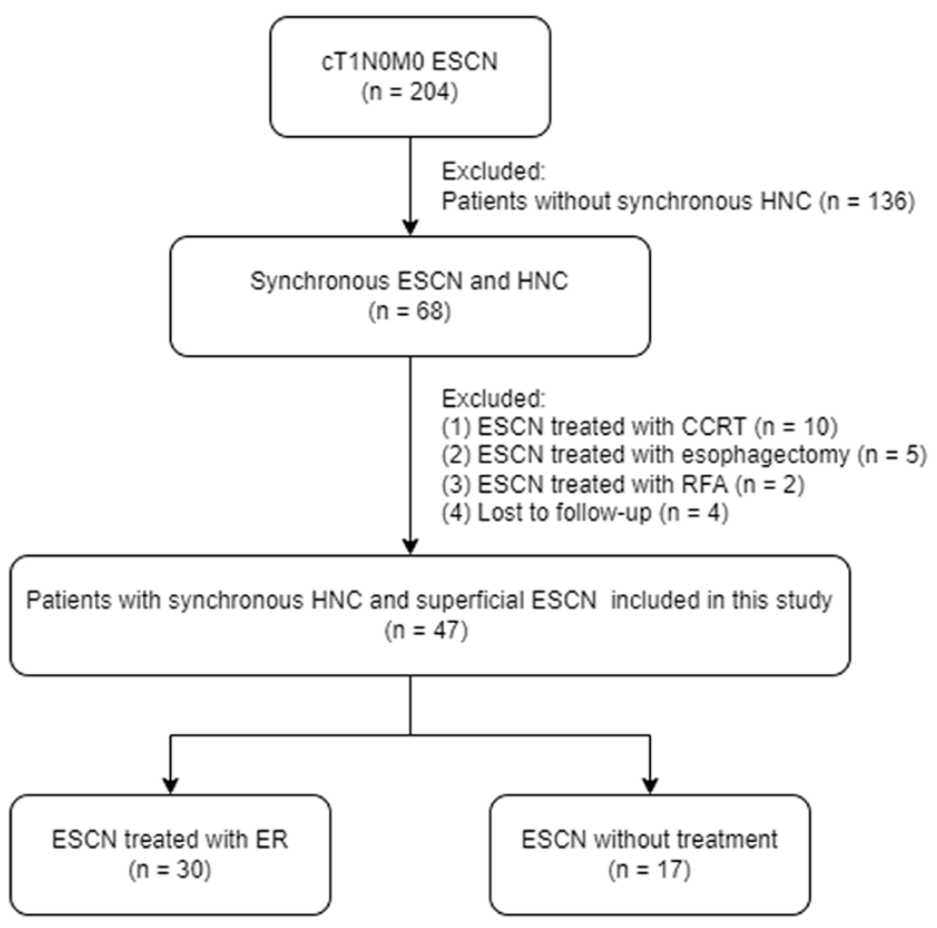
Figure 1. Flowchart of the study. Abbreviations: ESCN, esophageal squamous cell neoplasm; HNC, head and neck cancer; CCRT, concurrent chemoradiotherapy: RFA, radiofrequency ablation; ER, endoscopic resection.